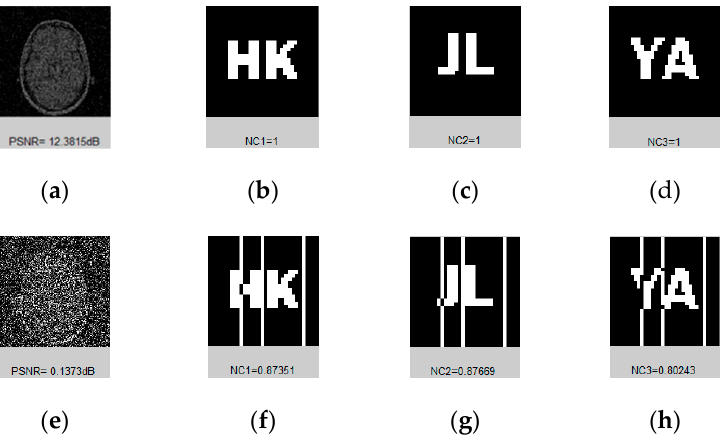
Figure 15. Under Gaussian noise attacks: ( a ) Gaussian noise level of 1%; ( b ) the extracted watermark 1 with a Gaussian noise level of 1%; ( c ) the extracted watermark 2 with a Gaussian noise level of 1%; ( d ) the extracted watermark 3 with a Gaussian noise level of 1%; ( e ) Gaussian noise level of 25%; ( f ) the extracted watermark 1 with a Gaussian noise level of 25%; ( g ) watermark 2 with a Gaussian noise level of 25%; ( h ) watermark 3 with a Gaussian noise level of